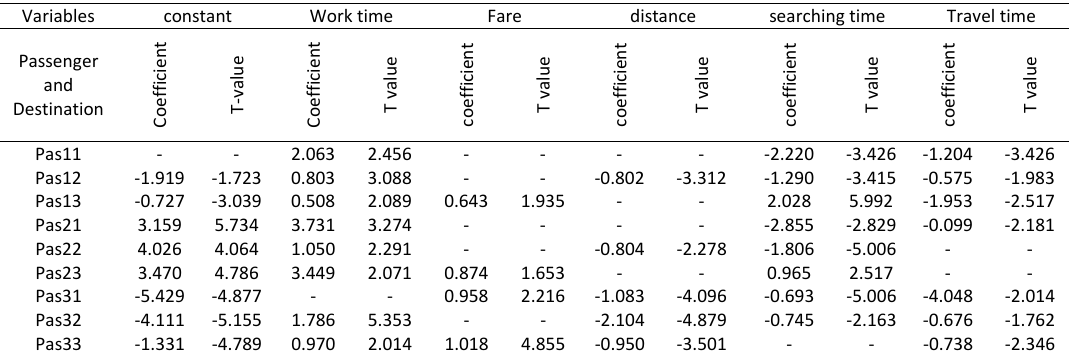
Table 3.Result of simultaneous multinomial logit model Table 3. Result of simultaneous multinomial logit